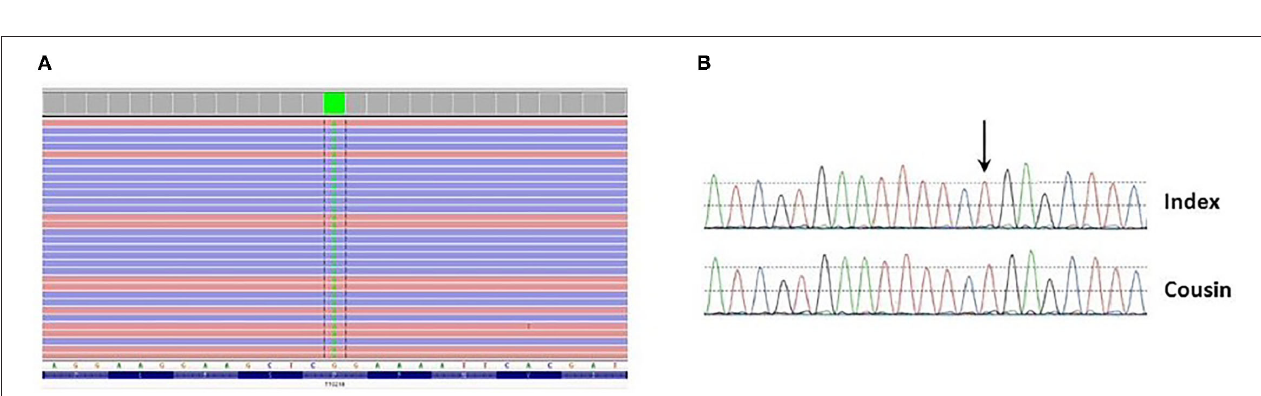
FIGURE 5 | (A) Presence of the c.626C > T p.(Pro209Leu) variant (green block) at homozygous state in exon 6 of the TTC21B gene found through clinical exome sequencing and visualized in Integrative Genomics Viewer (IGV). (B) Presence of the variant at homozygous state in the patient and her cousin was confirmed by Sanger